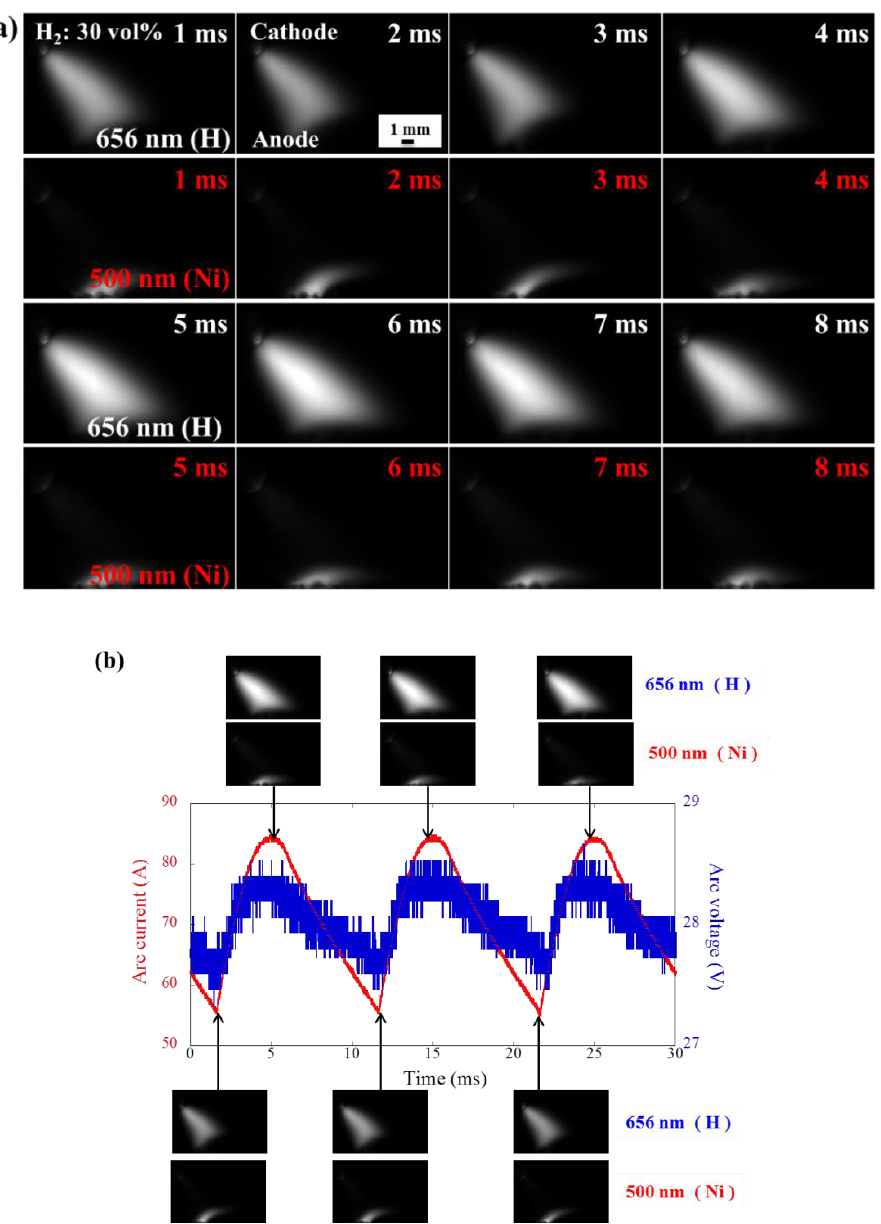
Figure 3. ( a ) Representative snapshots of a high-speed camera in argon arc when hydrogen concentration is 30 vol%. H emission is the upper one, and Ni emission is the lower one; ( b ) corresponding voltage and current waveform of argon arc synchronized with the snapshots of H and Ni emissions.